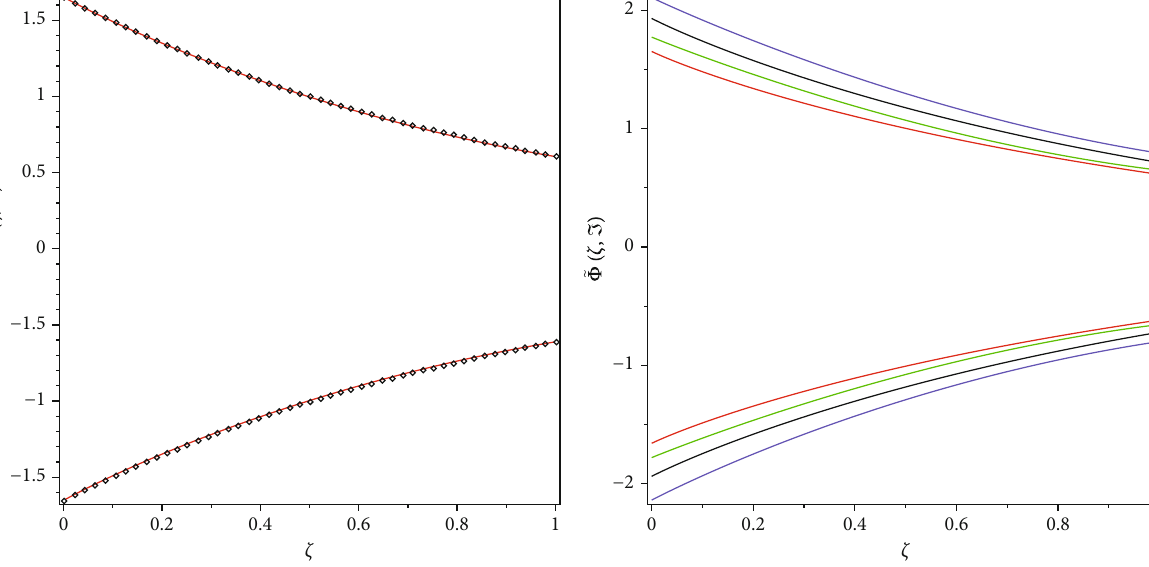
Figure 4: First graph shows the two-dimensional fuzzy lower and upper branch graph of analytical series solution and second graph the di ff erent fractional-order of ν